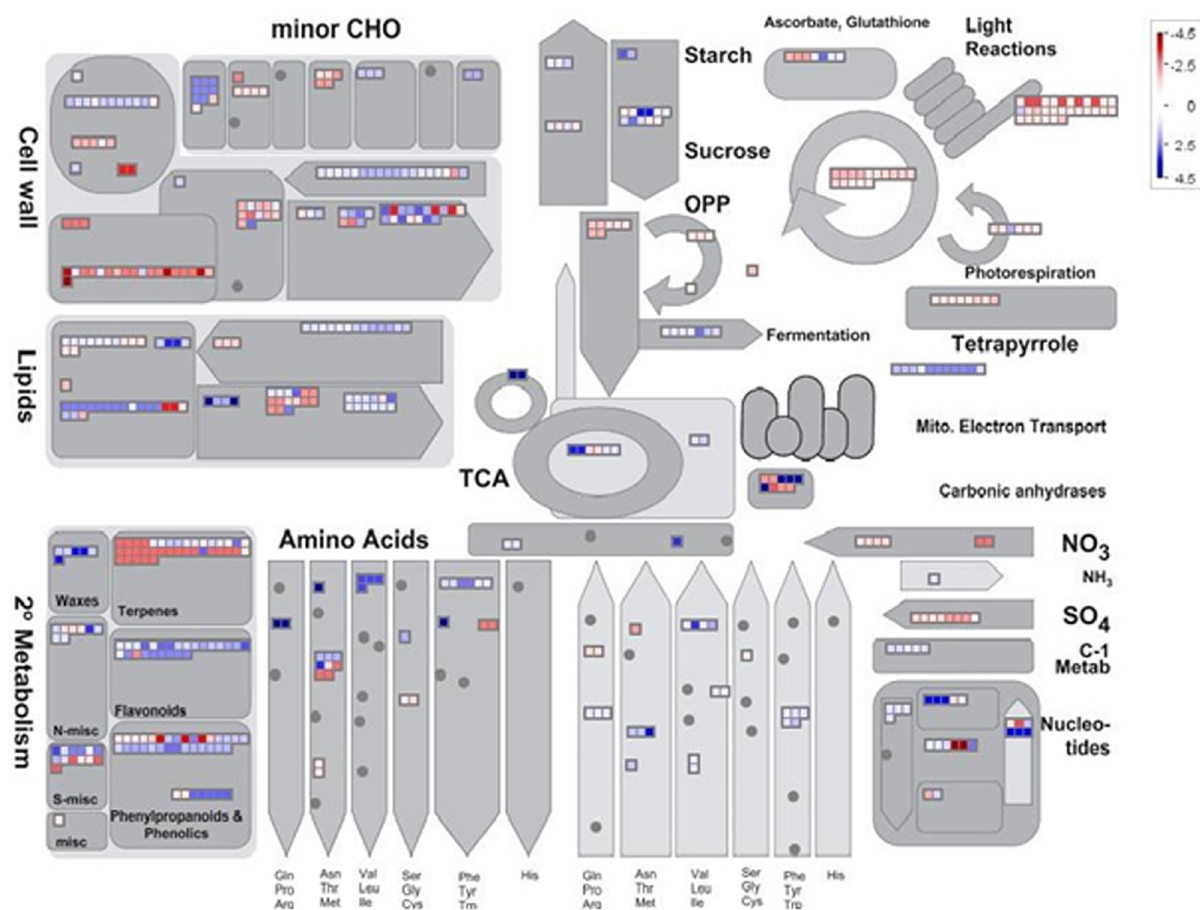
Fig 3. Metabolic pathway overview of the DEGs in Arg cultivar under salinity stress utilizing Mapman. The down- and up-regulated genes are shown in red and blue, respectively.